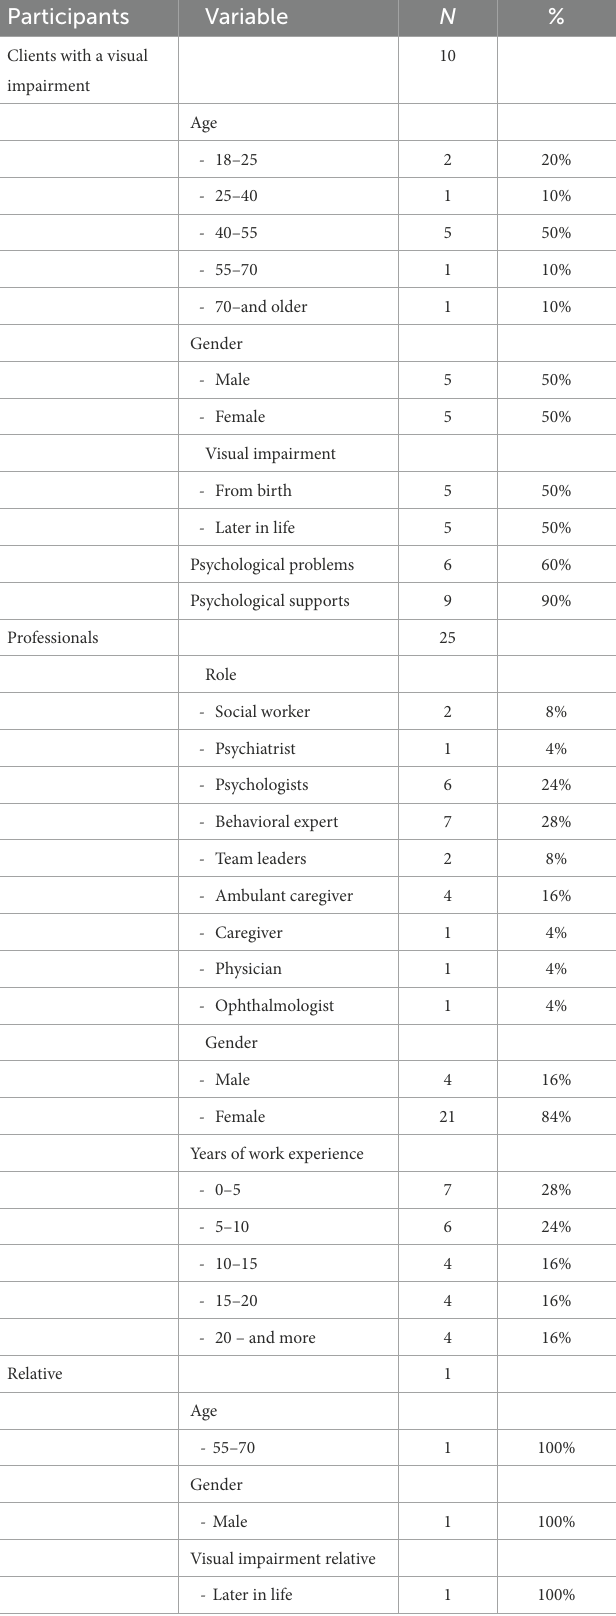
TABLE 2 Participants